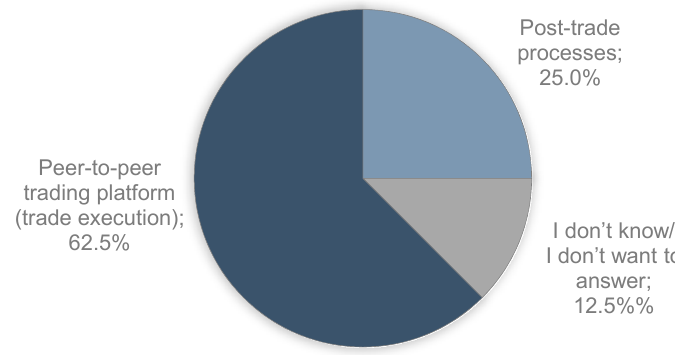
Figure 9. First commercial use case.